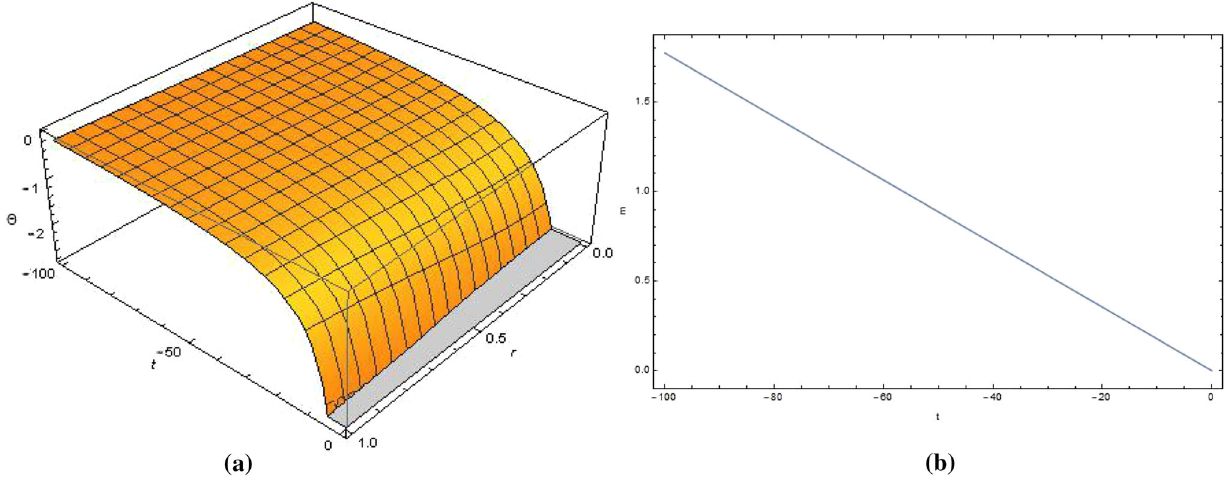
out the collapse. As the star deviates from the equilibrium, it will start radiating heat and as the contraction of the cloud increases it will start radiating more and more heat flux. It can be seen from the graph that the heat flux starts to increase as the collapse starts at t = − 100 and heat flux is positive and maximum as it reaches the end state of the collapse at t = 0